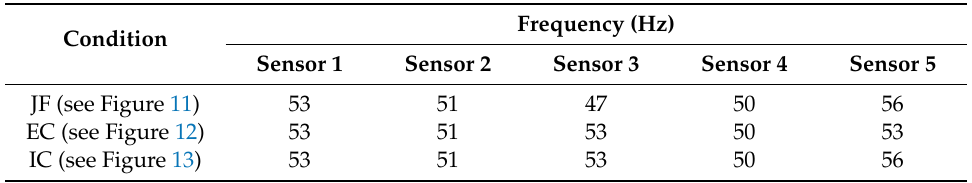
Table 1. Selected frequency peak regions for each sensor to locate the damaged bay for the conditions joint failure (JF), external corrosion (EC) and internal corrosion (IC).